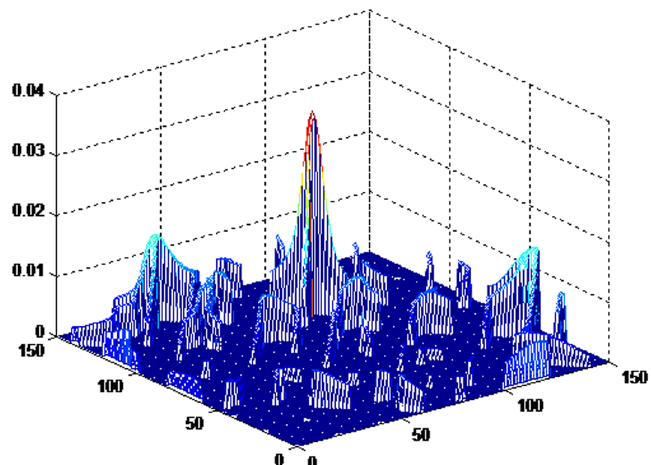
Fig. 8 Example of the correlation surface to the hill-climbing method